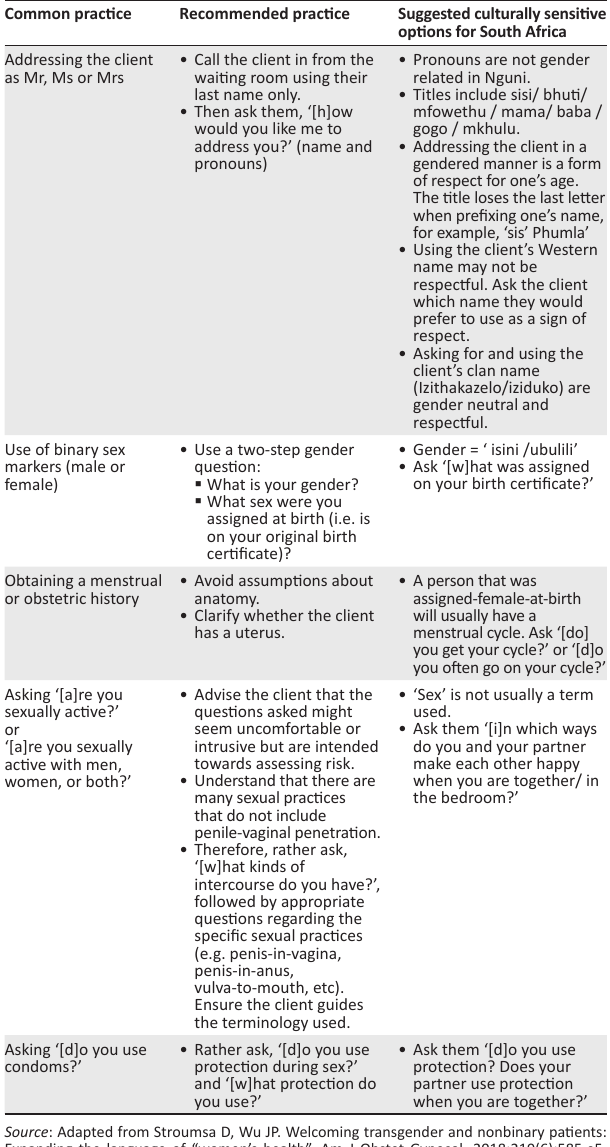
TABLE 2: Gender-inclusive language for taking a sexual